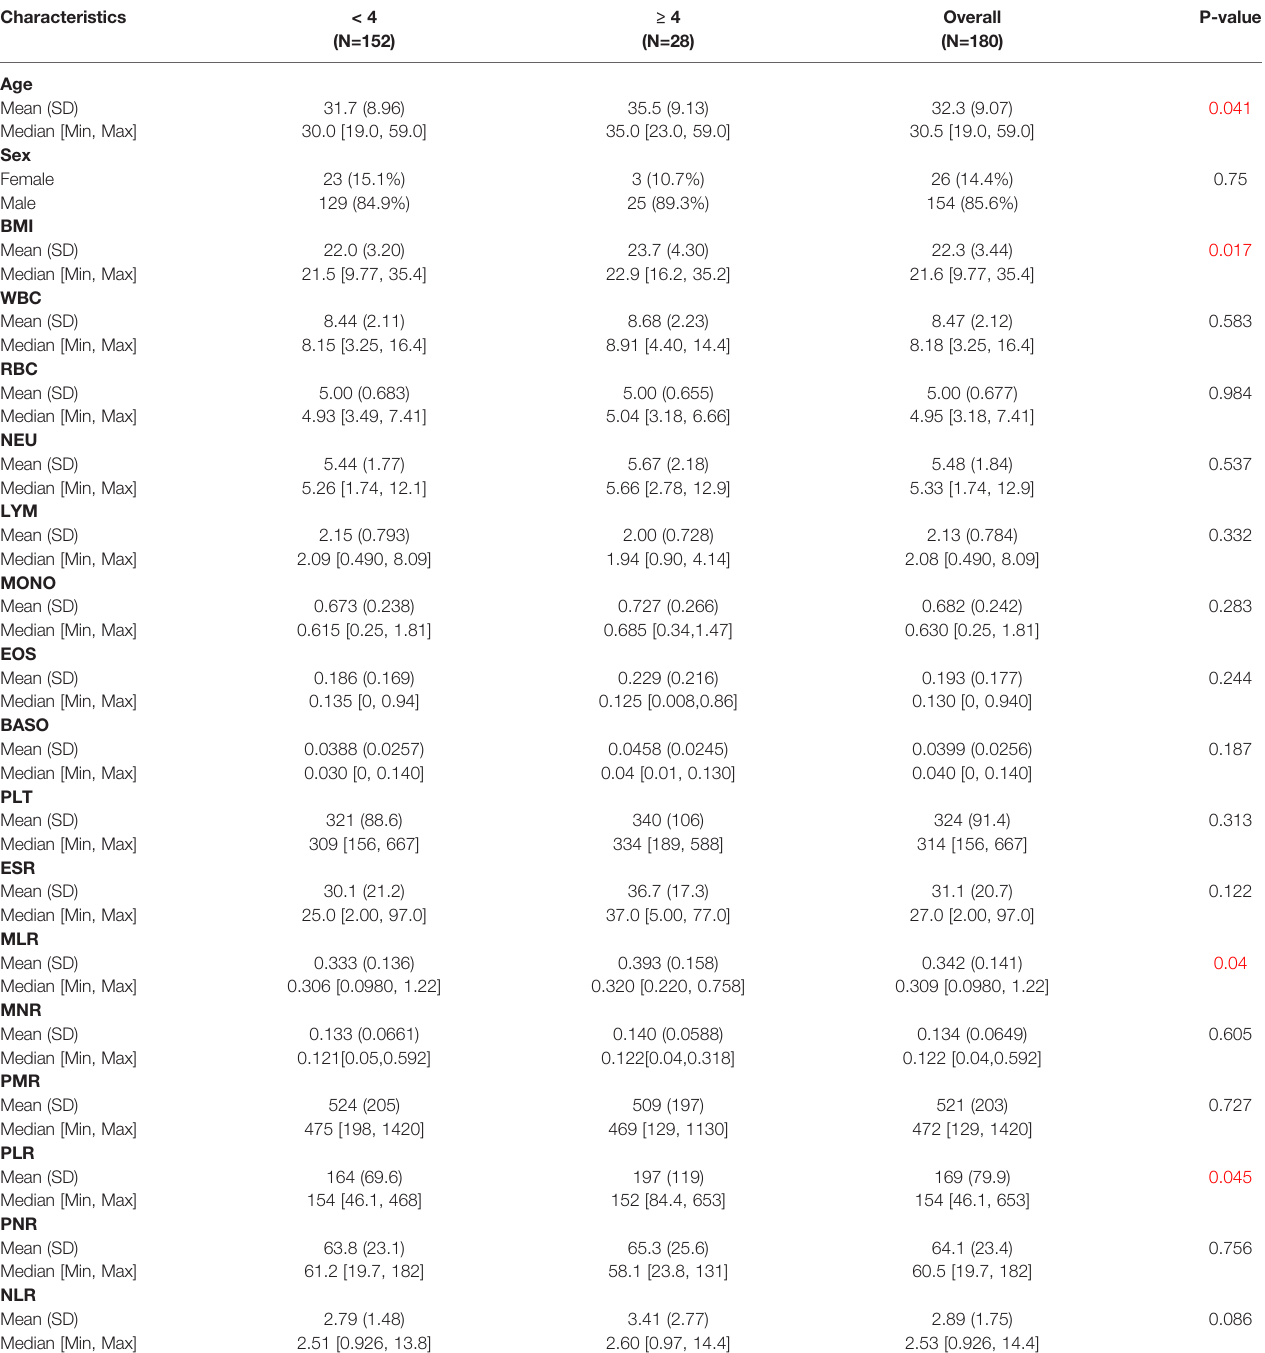
TABLE 2 | Baseline characteristics between BASDAI socre < 4 or ≥ 4 in AS patients. Characteristics Overall P-value